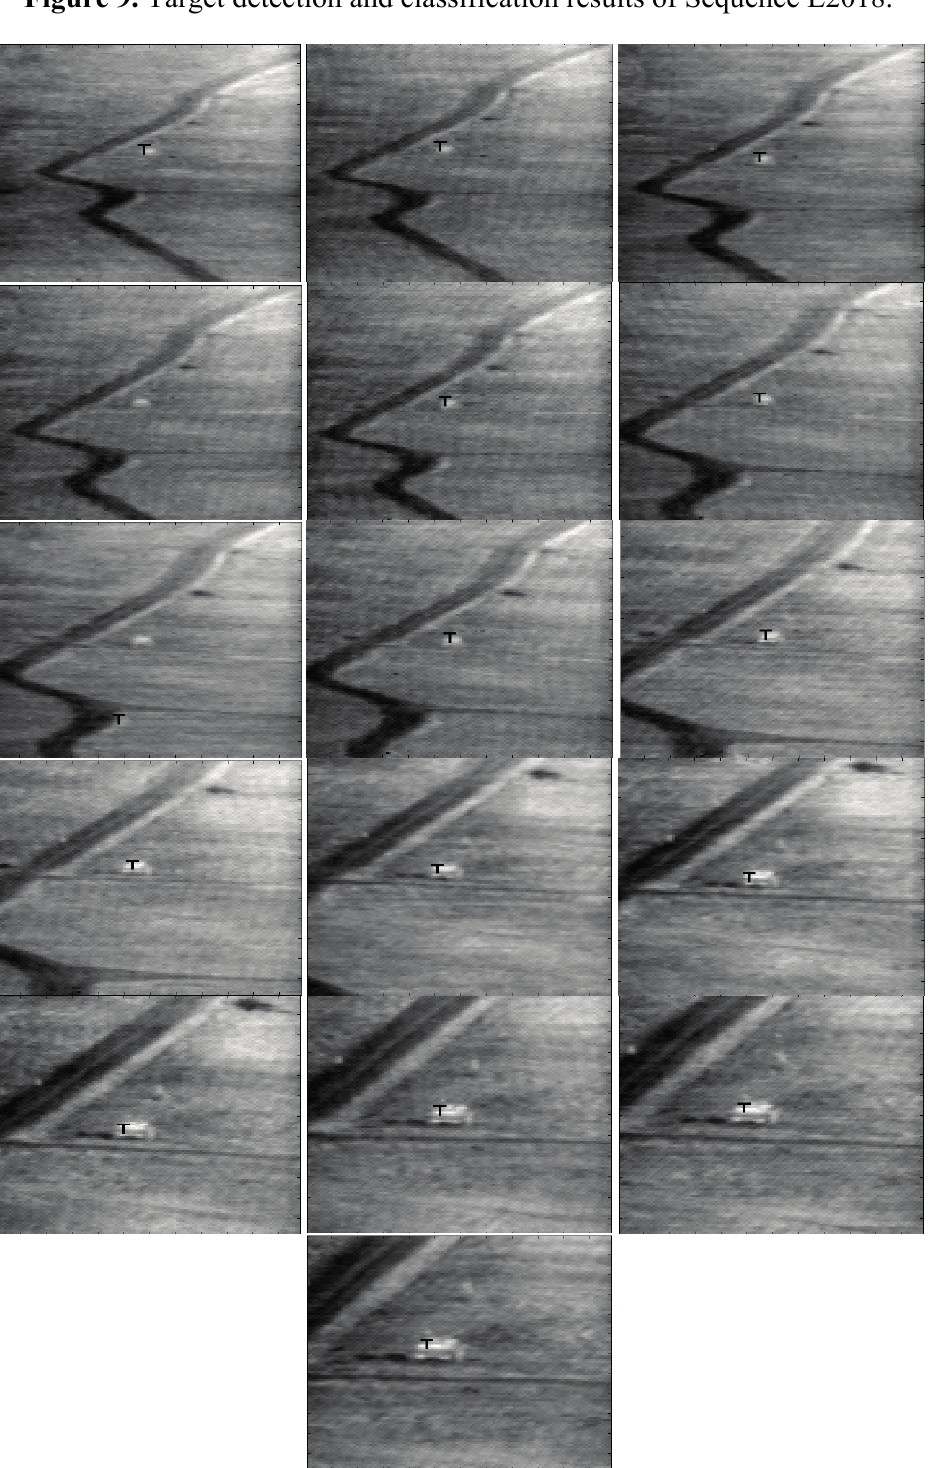
Figure 9. Target detection and classification results of Sequence